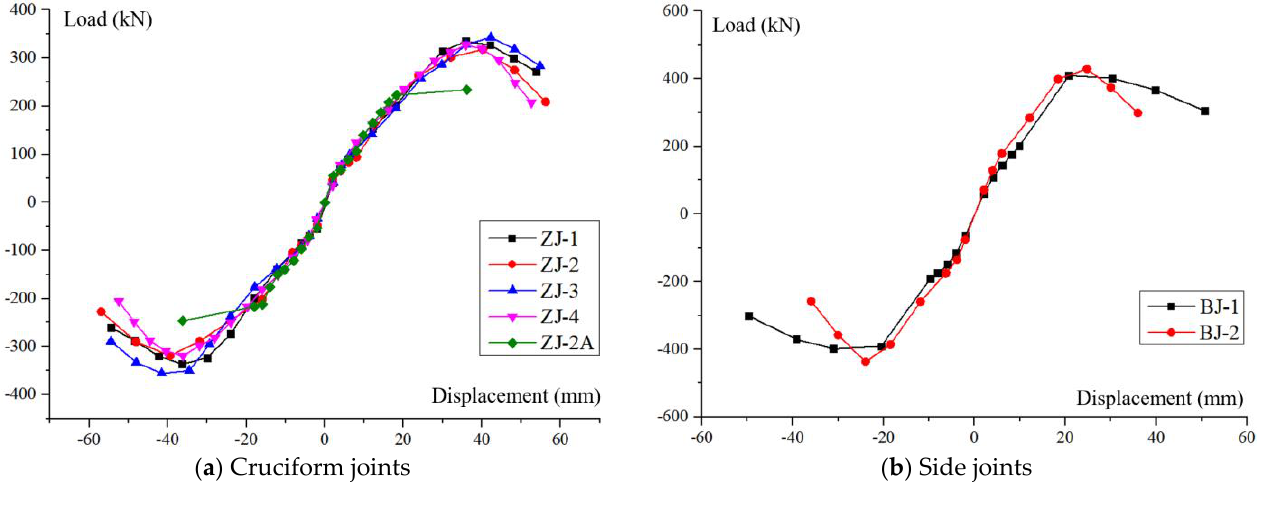
Table 5. Bearing capacity, displacement and ductility factors of specimens.